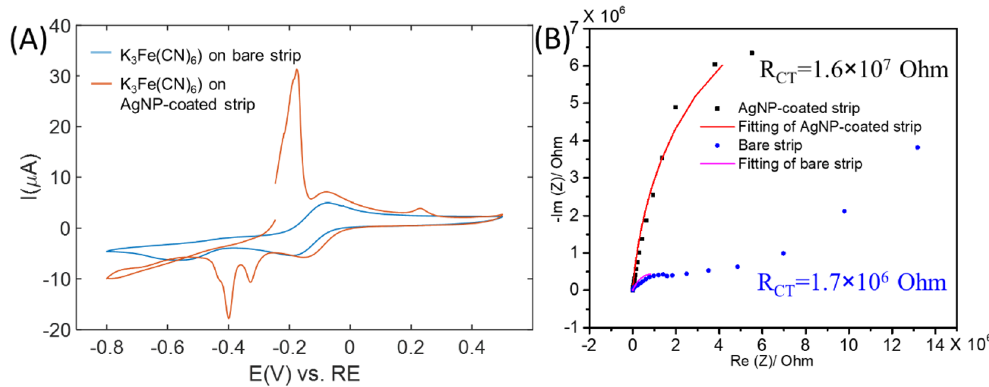
Figure 4. EC evaluation of the AgNP-coated test strip. ( A ) Electrochemical evaluation with K 3 Fe(CN) 6 and ( B ) EIS of bare and AgNP-coated glucose test strip. Electrolyte: 0.1 M KCl for K 3 Fe(CN) 6 (5 mM), and 0.1 M NaOH for EIS; scan rate for CV: 20